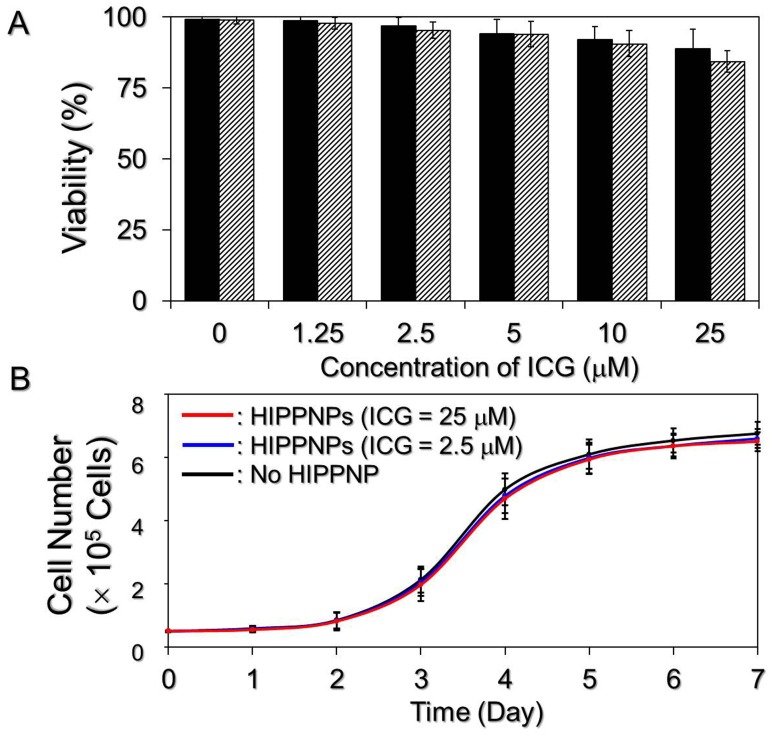
Cytotoxicity of HIPPNPs to breast cancer cells in the absence of light illumination.(A) Viabilities of MDA-MB-453 cells after treated with HIPPNPs in 0 (no HIPPNP), 1.25, 2.5, 5, 10, and 25 μM ICG equivalent without light illumination for 24 (solid) and 48 (stripe) h. The cellular viability of each group was measured by hemocytometry with trypan blue exclusion method. Values are mean ± SD (n = 3). (B) Growth kinetic curves of MDA-MB-453 cells after treated with HIPPNPs. The cells treated by HIPPNPs with 0, 2.5, and 25 μM ICG equivalent were continuously cultivated at 37°C after the viability test and the growth kinetic curve of each group was established through the measurements of cell number every 24 h for 7 days. Values are mean ± SD (n = 3).